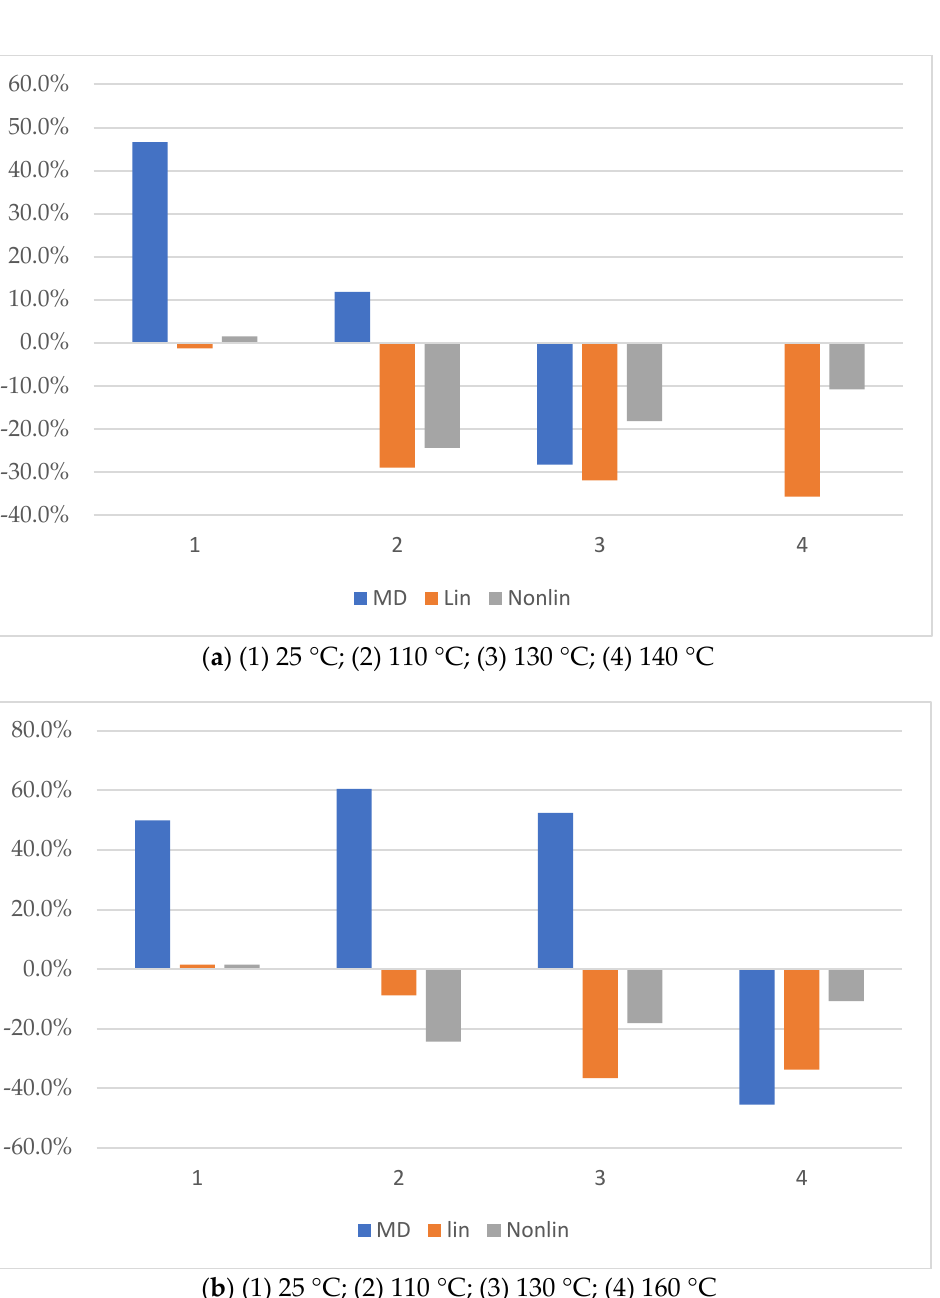
16 of 22 Figure 11. Dependence of elastic modulus on temperature: (c) experimental for the fiberglass spec- imen before exposure at high temperature; (d) experimental for the fiberglass specimen after expo- sure at high temperature; (e) computational for the linear calculation of a multilayer composite be- fore exposure at high temperature; (f) computational for the linear calculation of a multilayer com-